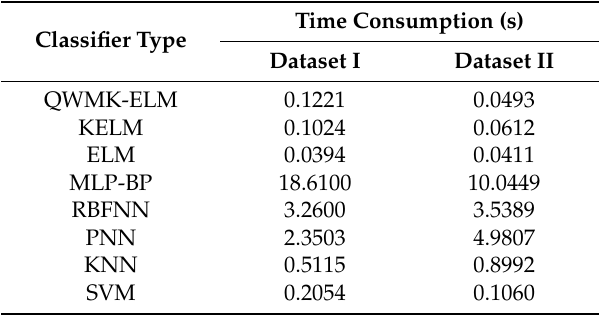
Table 7. Time consumption of QWMK-ELM and the control methods.